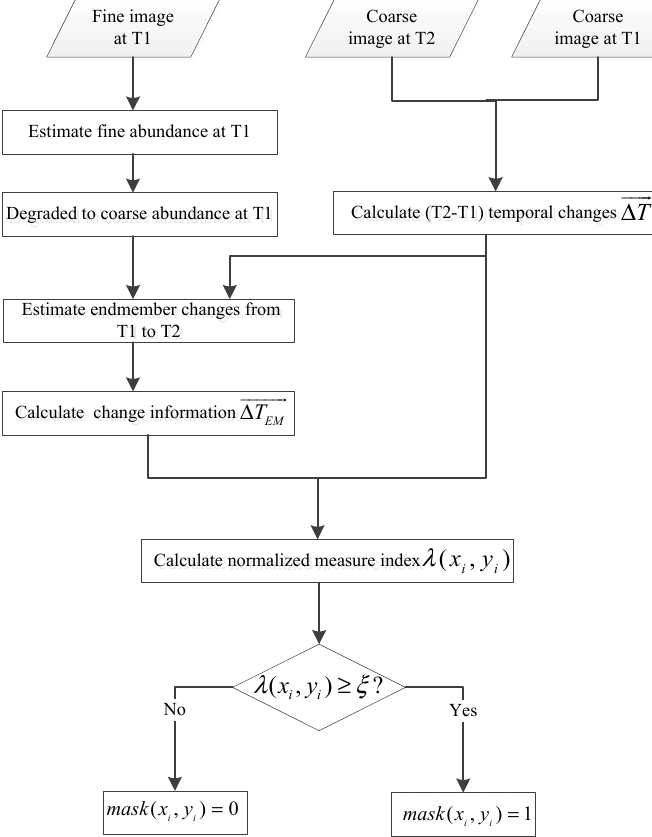
Figure 2. Flowchart of the calculation of the guided mask map in adaptive-SFSDAF.